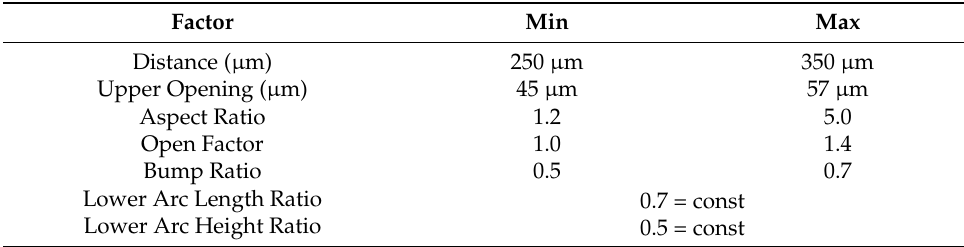
Table 4. Factors and limits for the sample generation.